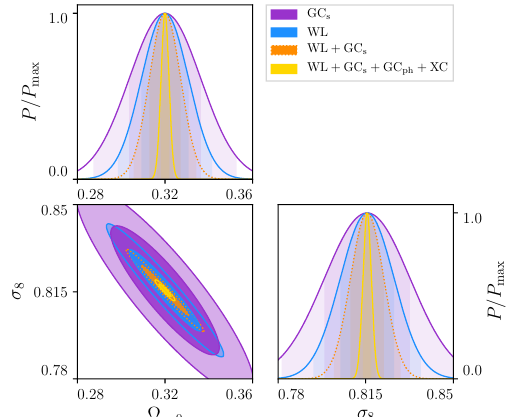
Figure 1. This picture illustrates the role of including cross-correlations when possible. These are the forecasts on the constraints expected from the Euclid space mission for a CPL flat cosmology, for the density parameter Ω m,0 and the amplitude of matter fluctuations σ 8 for spectroscopic sample (purple), weak-lensing (blue), their combination (orange), and with the addition of the cross-correlation between the photometric sample and the weak-lensing (yellow), currently denoted 3 × 2 pt. From